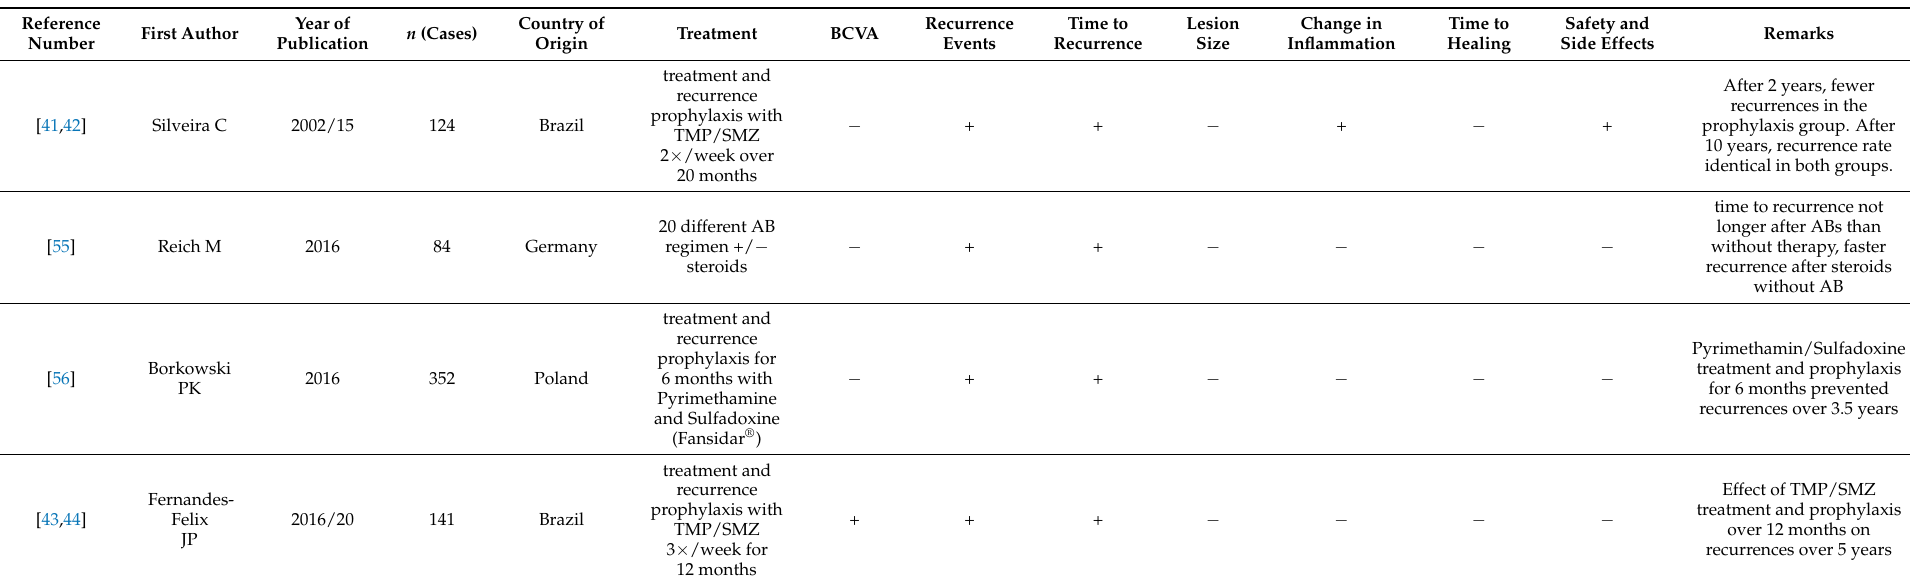
Table 3. Prophylaxis of OT recurrences. Overview of registered primary and secondary outcome